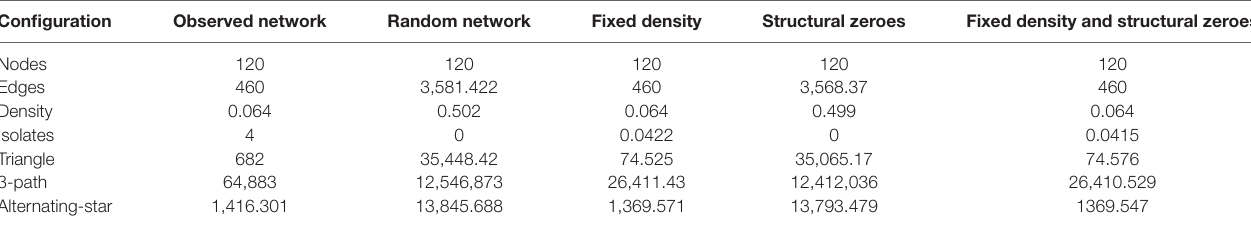
TaBle 3 | Count of visibility network configurations in the total viewshed network shown in Figure 4 above, and in four different Bernoulli random graph models (10,000 randomly generated networks with 120 nodes).